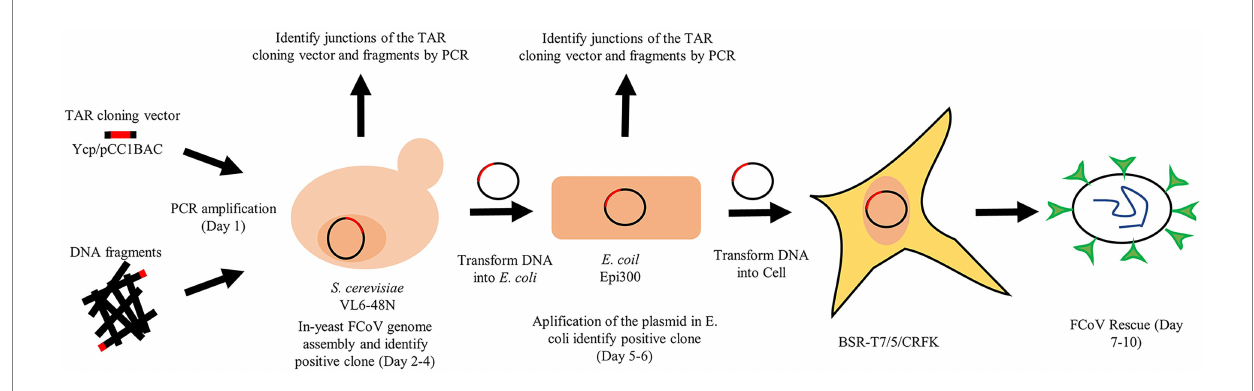
FIGURE 1 The full process of viral genome assembly and virus